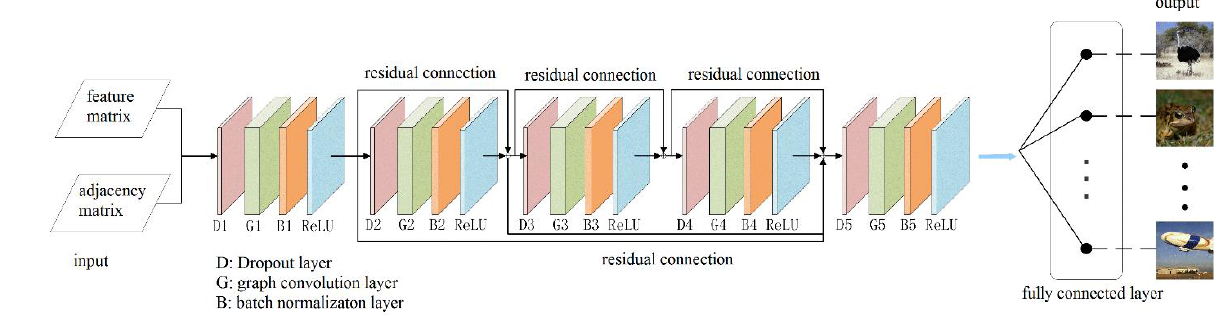
Figure 4. The network structure of the proposed GCN.